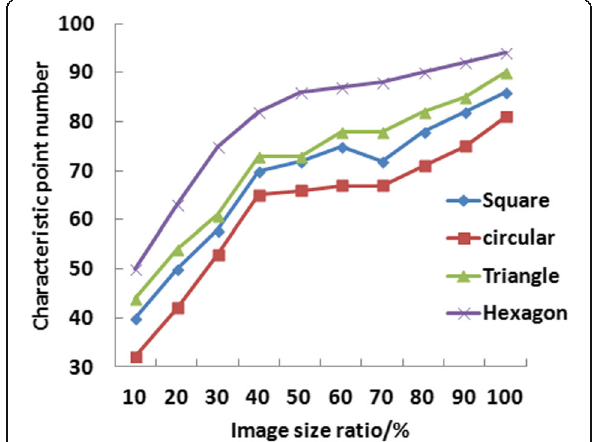
Fig. 10 Relationship between feature points and image size of images of different shapes